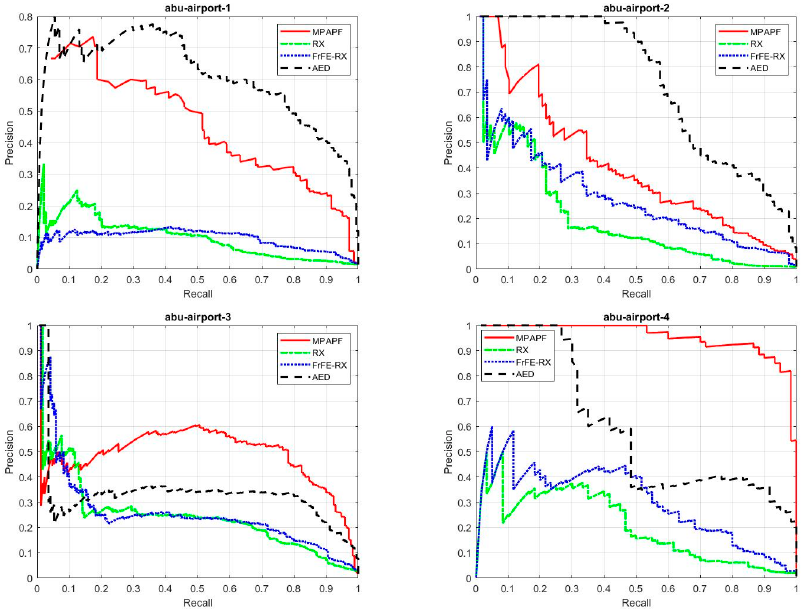
Figure 10. Precision-recall curves of the compared methods on the ABU-Airport Scene.